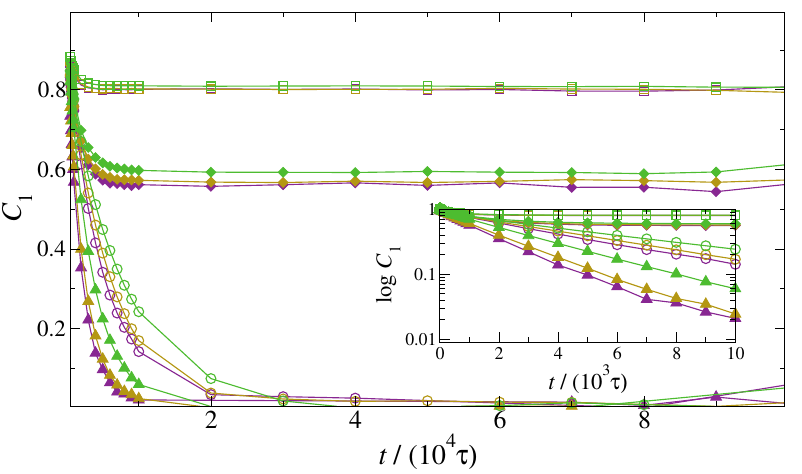
Figure 9. Time autocorrelation functions of the orientation of NDs. The inset provides a zoom at short time scales (notice the log-lin scale). Systems containing 00 (empty circles), HH (solid triangles), H0 (solid diamonds) and HT (empty squares) NDs are shown at particle mass fractions 1wt% (purple), 5wt% (yellow) and 10wt%